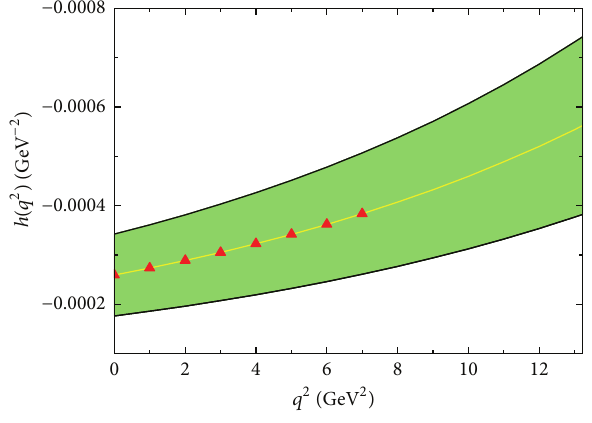
Figure 4: The same as Figure 3 but for ℎ(𝑞 2 ) .